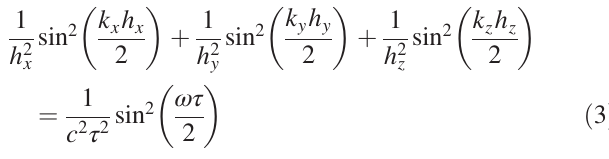
FIG. 2. Transverse force at t=T b ¼ 10 for a fixed x value of ð x − ct Þ = σ ¼ 10 . Transverse force obtained by the Yee solver 0 uses the red y